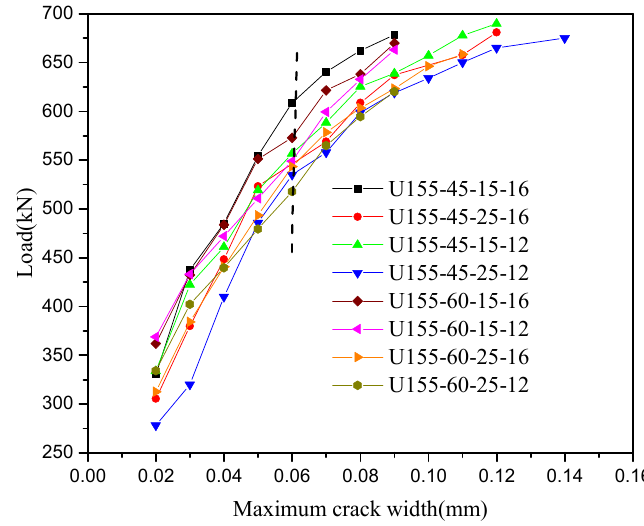
Figure 11. Load-maximum crack width curves of steel-UHPFRC composite beams.